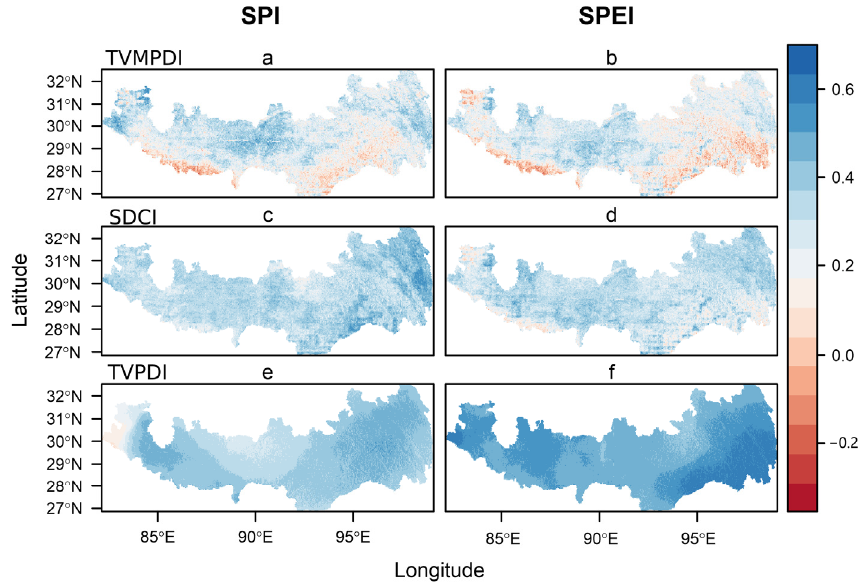
Figure 4. Temporal correlation between the TVMPDI ( a , b ), SDCI ( c , d ) and TVPDI ( e , f ) with SPI and SPEI.